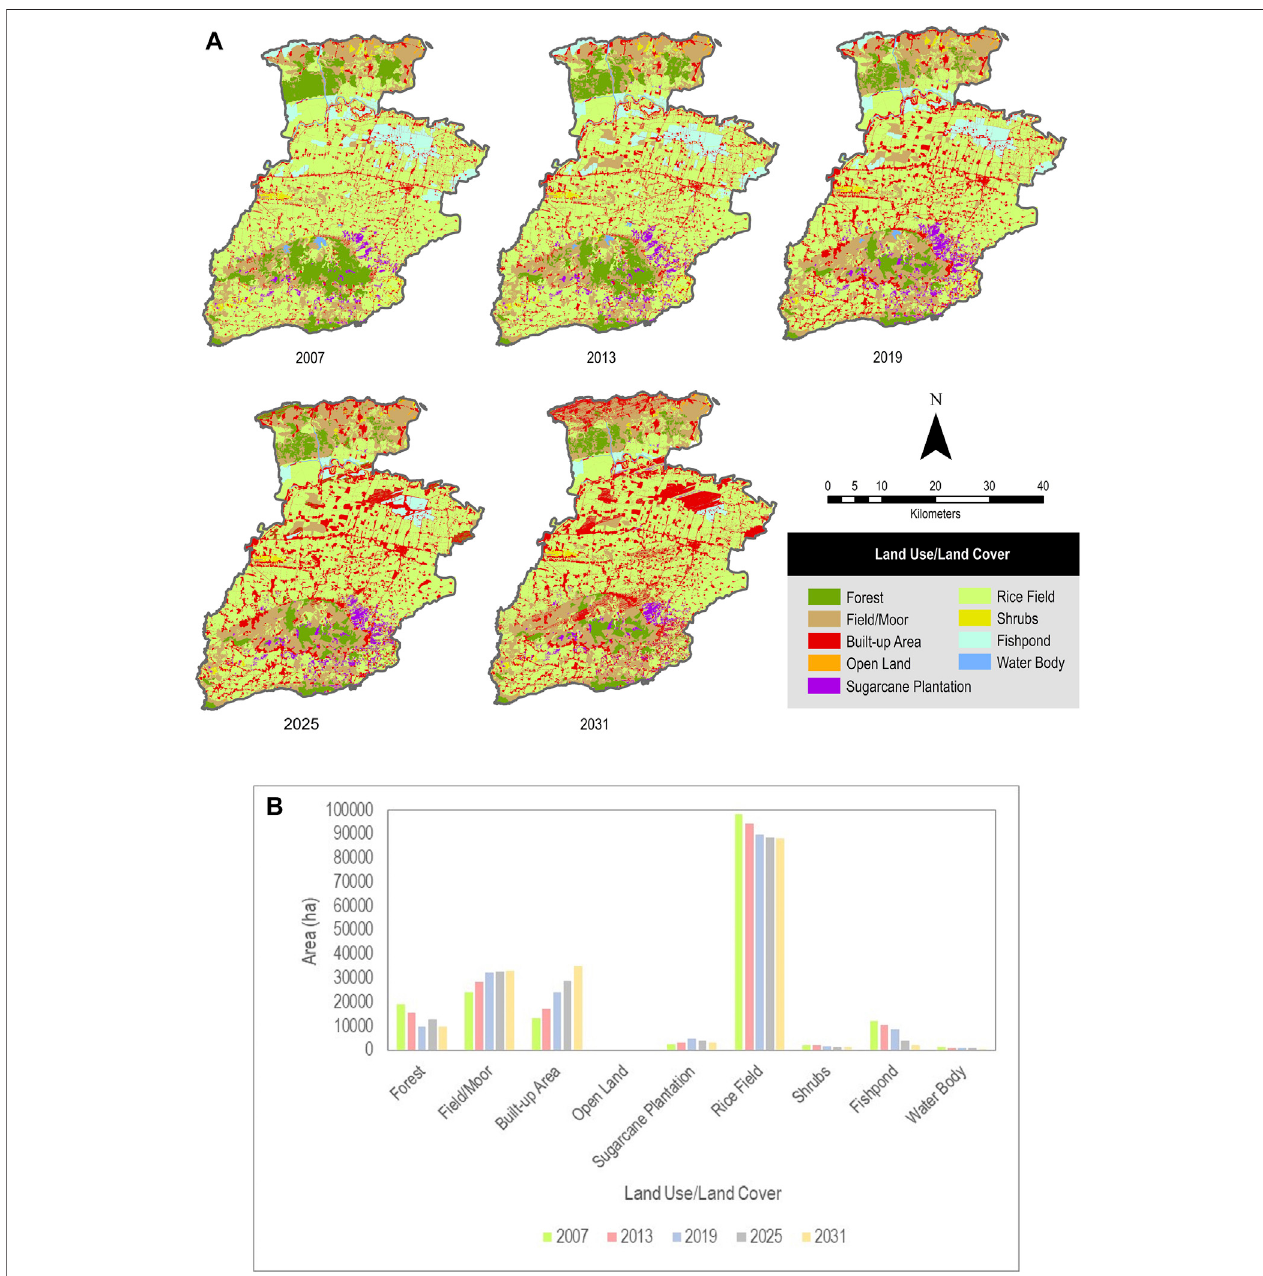
FIGURE2| ThedistributionofLULCinLamonganRegencyin2007,2013,2019,andtheanticipatedresultsforLULCinLamonganRegencyin2025and2031 (A) ; graph of change of each LULC (B) .